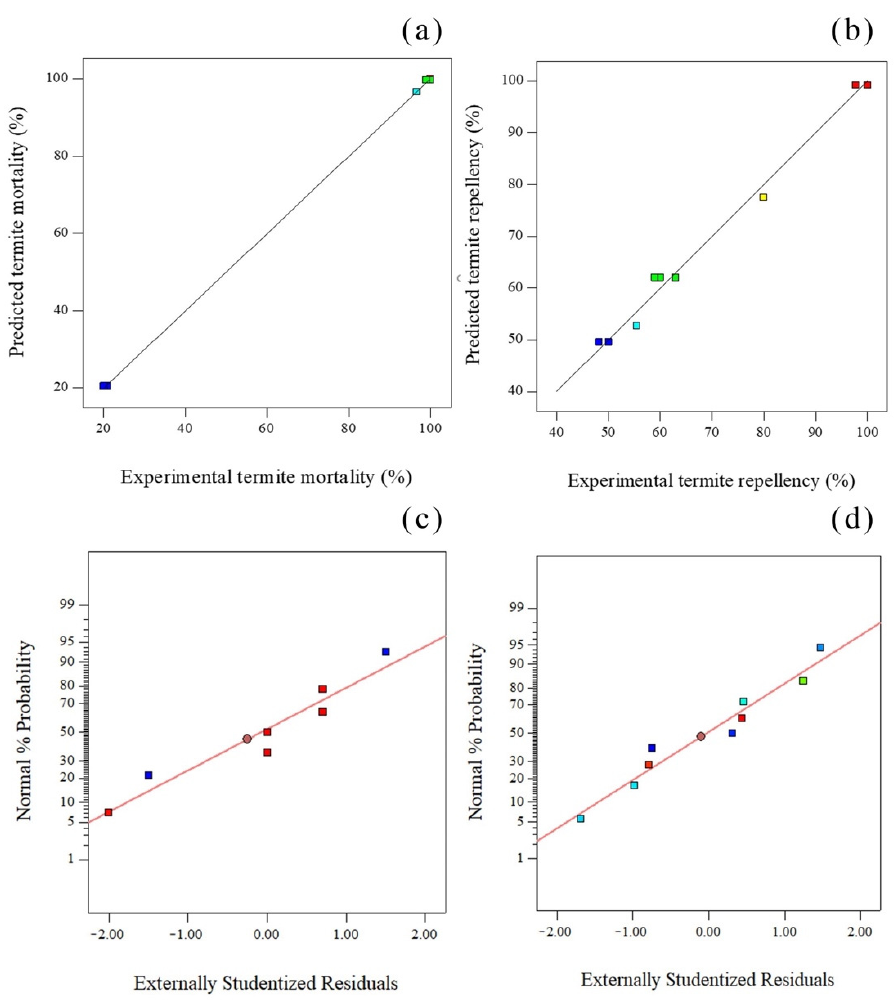
Figure 1. Experimental versus predicted values for one-factor design: ( a ) termite mortality (R 2 = 0.9999; adjusted R 2 = 0.9998), ( b ) repellency (R 2 = 0.9894; adjusted R 2 = 0.9858). ( c , d ) Normal distribution of experimental data.